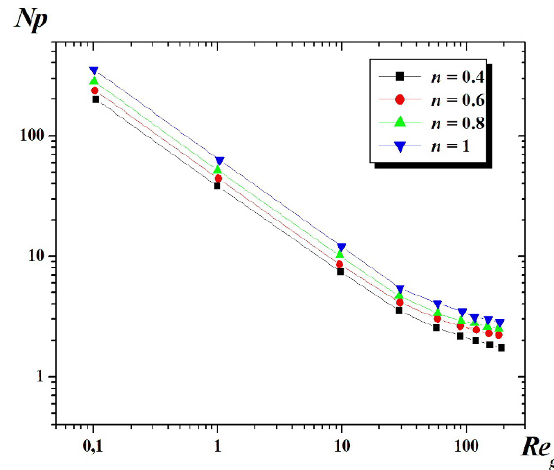
Figure 14. Power number for double helical ribbon impeller, c/D = 0.26, h/D =